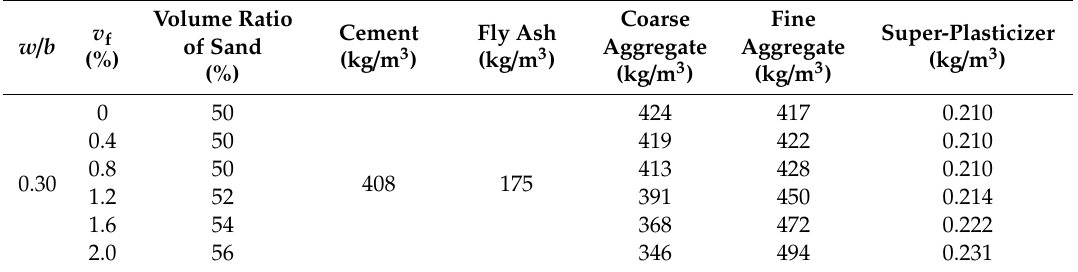
Table 3. Mix proportion of self-compacting SFRELC.